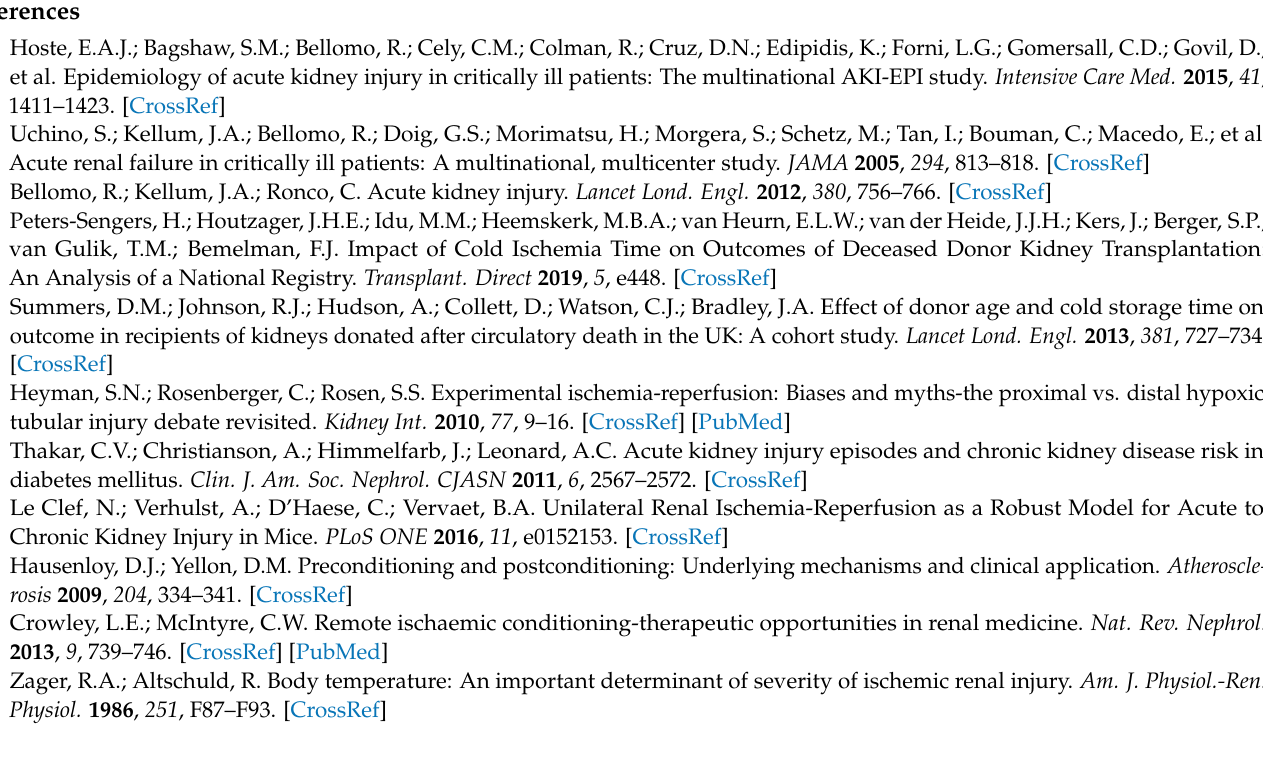
Table S4: Enrichment of KEGG pathways with genes modified by anesthesia during ischemia reper- fusion (non-directional analysis and directional analysis). Table S5: List of genes that are upregulated by ischemia. Table S6: List of genes that are downregulated by anaesthesia. Table S7: List of genes that are downregulated by ischemia and upregulated by anaesthesia. Video S1: Assessment of the efficacy of repeated vascular occlusions by ultrasound